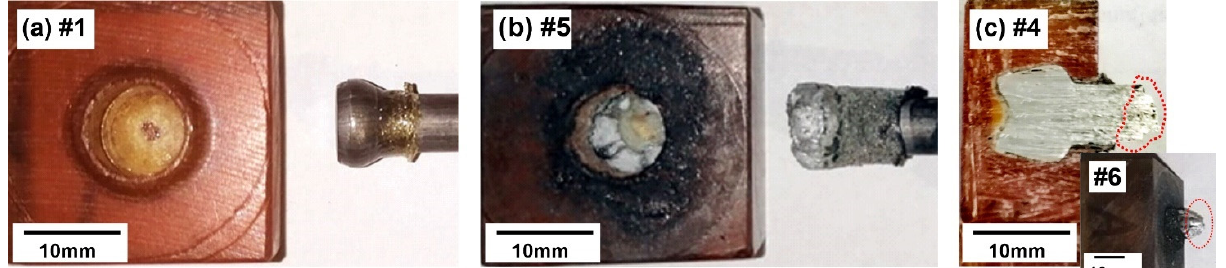
Figure 8. Three main types of joint failures; ( a ) failure in the PEI base material, ( b ) failure in the deformed section of the rivet with an anchor shape and ( c ) failure in the undeformed section of the AA2024-T351 rivet—red colour (* Note : numbers by the image captions represent the sample/parameters designation using different manufacturing parameters—see Table 1).